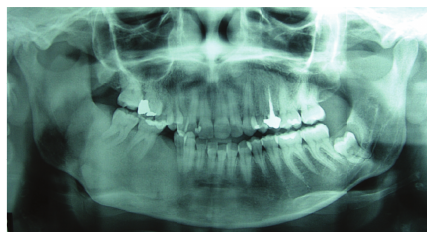
Figure 5: Panoramic X-ray (2013) showing radioopaque area of the image with the appearance of ground glass in the right hemi- mandible. Recurrence of the